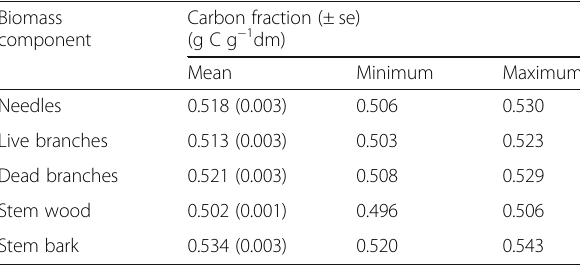
Table 2 Carbon fraction — summary of G × E trials sampled at approximately mid-rotation ages Component